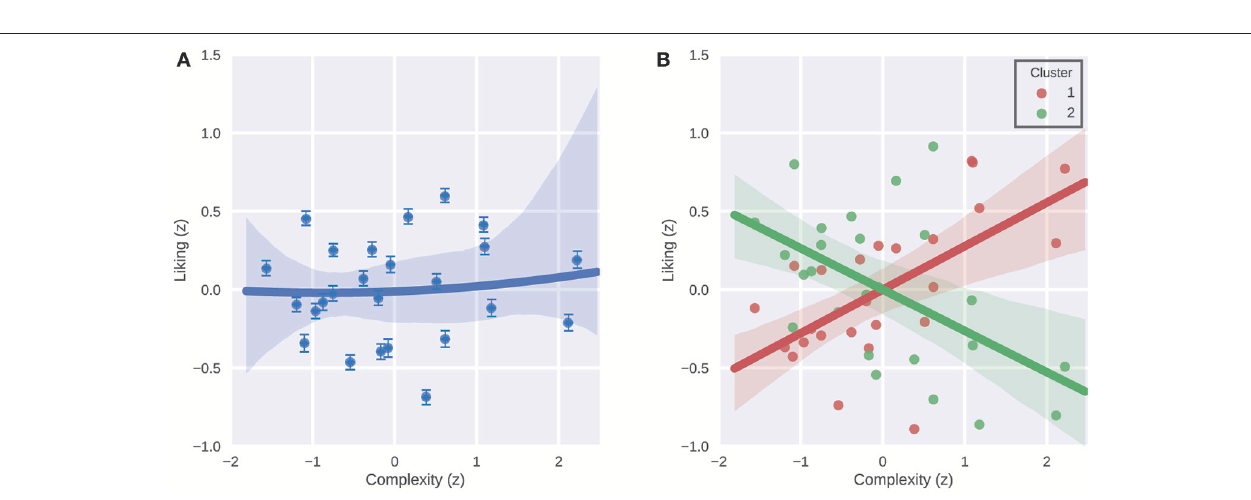
FIGURE 2 | Liking ratings of the participants as a function of stimulus complexity. (A) Average normalized liking ratings of all participants vs. normalized complexity scores of the 25 song excerpts. Dots represent the stimuli, and the line represents a quadratic function fit. Shaded area indicates error of fit and the error bars show the standard error of mean. (B) Average normalized liking ratings of participants in Cluster 1 and Cluster 2 separately vs. normalized complexity scores of the 25 song excerpts. Dots represent the stimuli, and the two lines represent the regression lines. Shaded area indicates error of